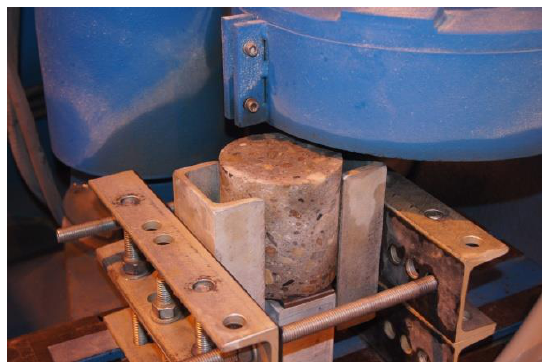
Figure 8. One of the core samples during grinding of its end surface.